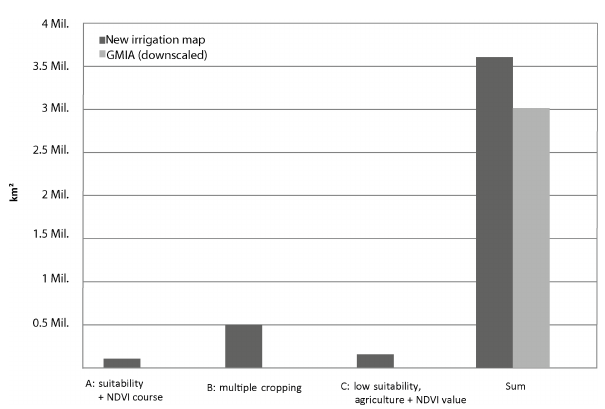
Figure 5. Results of the new irrigation map compared the down- scaled